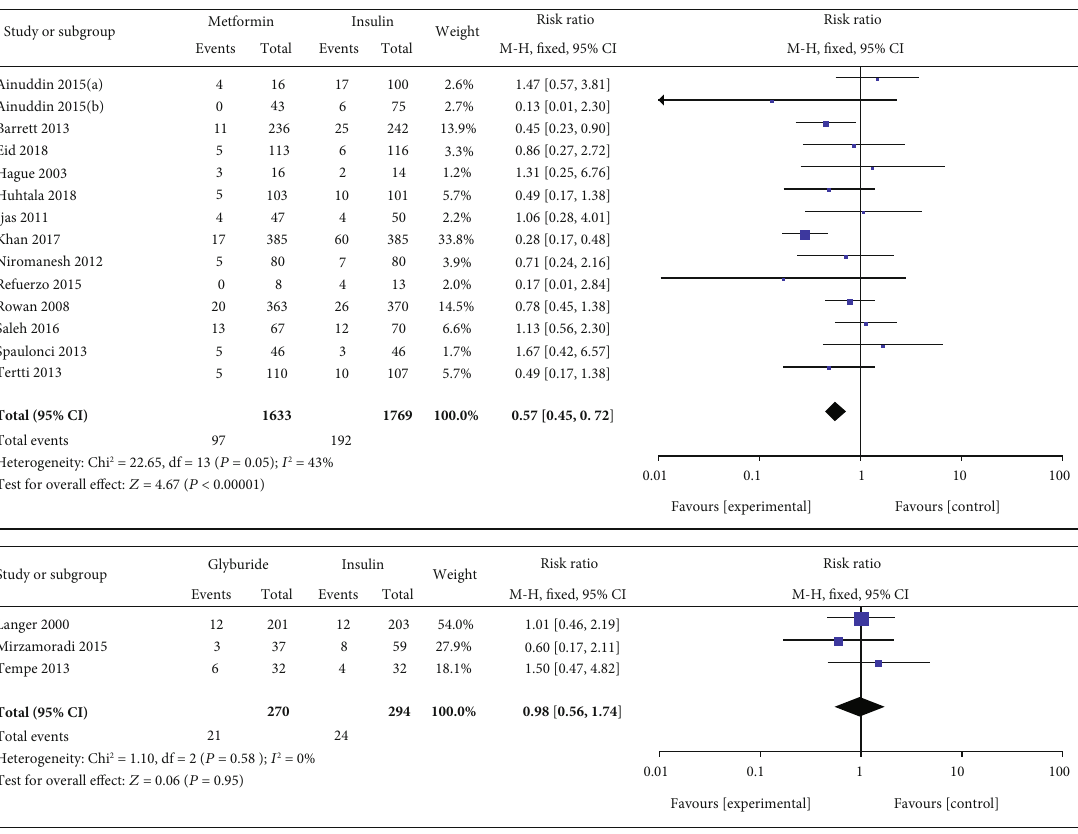
Figure 6: Preeclampsia.